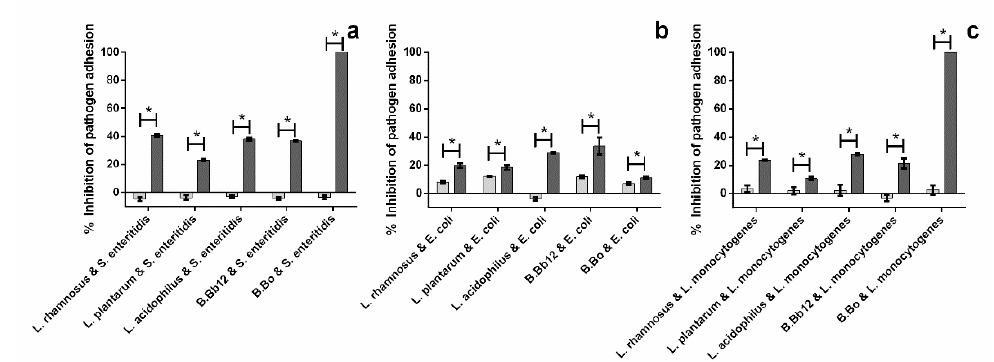
Figure 3. Impact of blueberry extract upon pathogen adhesion (presence ( (cid:4) ) and absence ( (cid:4) ) of extract) in the dual species pathogen/probiotic systems: ( a ) S. enteritidis /probiotic system, ( b ) E. coli /probiotic system, and ( c ) L. monocytogenes /probiotic system. The asterisks (*) mark statistically significant differences between sets of data ( p < 0.05).